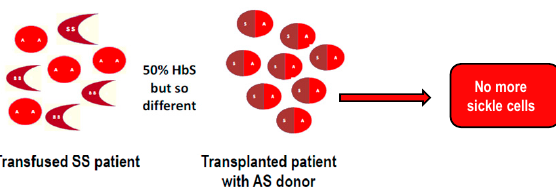
Figure 1. Difference between a transfused sickle-cell anemia (SCA)-patient who has a double population of sickle SS cells and transfused normal AA red cells and a transplanted patient who has only normal red blood cells as the donor (AS or AA) and no more sickle